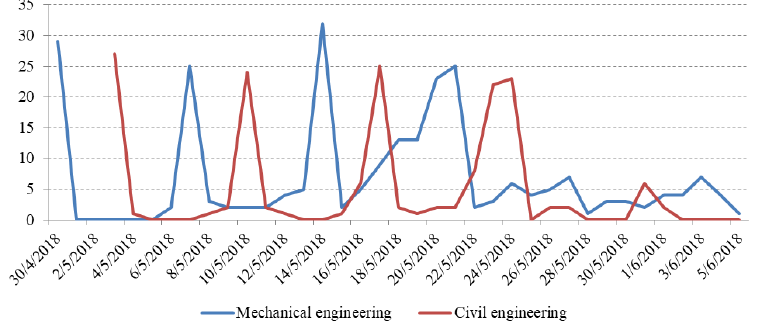
Fig. 4. The timeline depicting the days when the student groups worked on